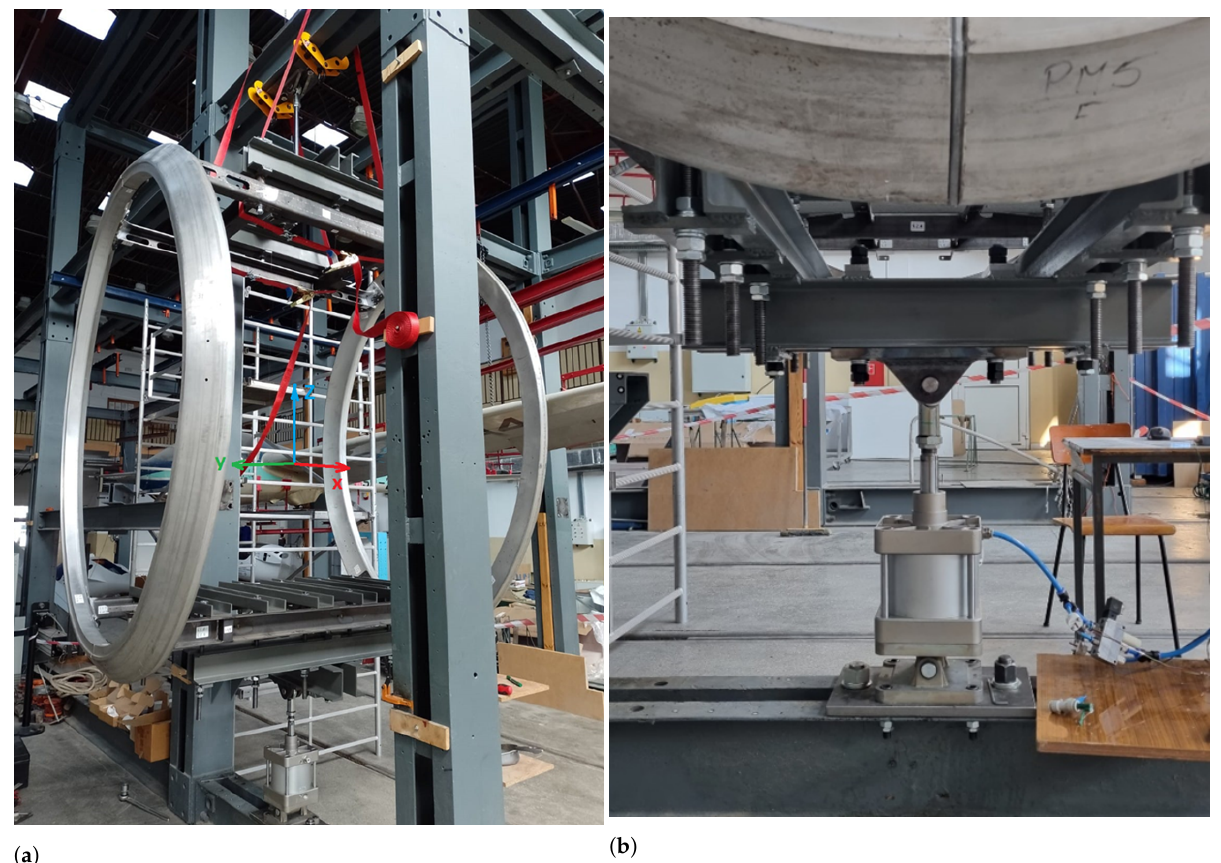
Figure 6. Mounted gondola with marked coordinate system ( a ) and the view of the mounted pneu- matic cylinder connected by an articulated connection with the C140 C-beam system for loading ( b